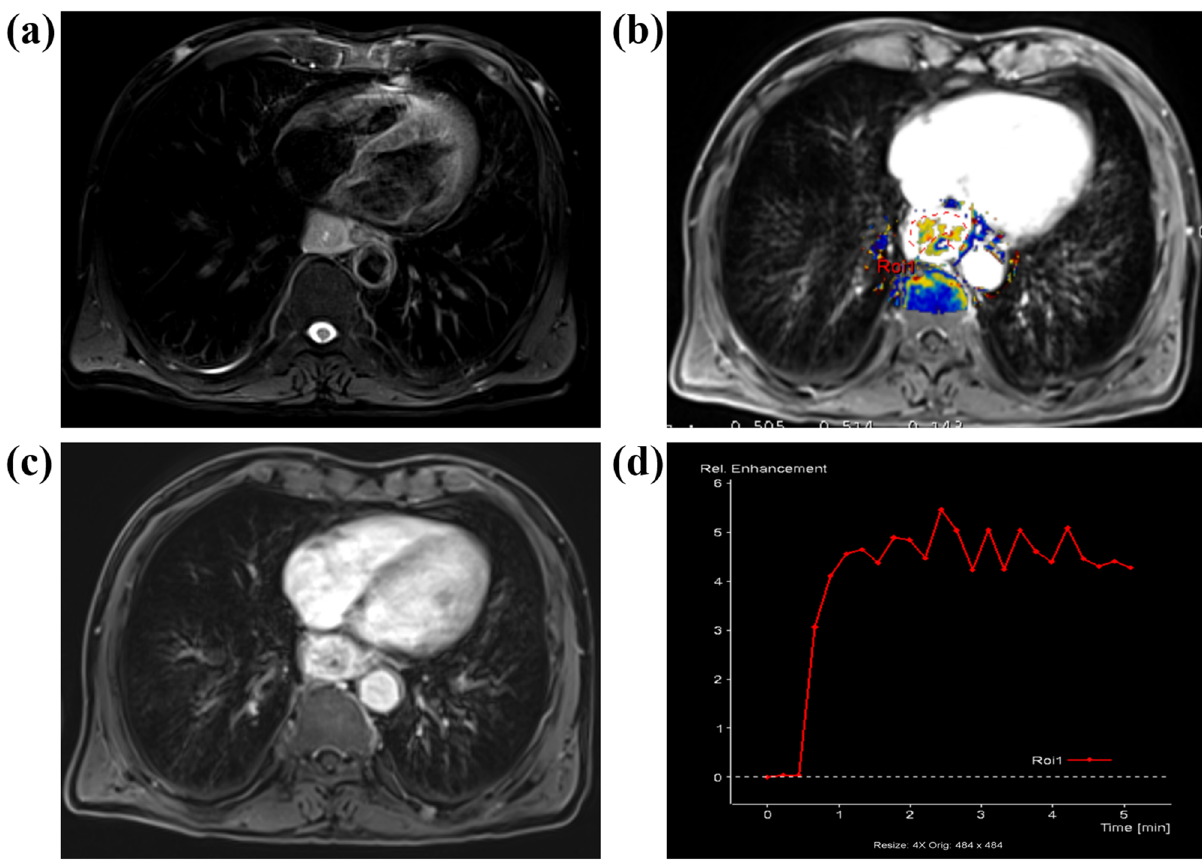
Figure 1. A patient (the age, 50–55) with esophageal carcinoma, perfusion scanning was performed with conventional 3D-VIBE sequence. ( a ) Obvious thickening of the esophageal wall and stenosis of the lumen was shown in the axial T2 fat depression image. ( b ) The pseudo-color map of Ktrans image. ( c ) The 13th stage image of the perfusion images. The inner and outer contours of the lesion are satisfactory, and the respiratory artifact is obvious. ( d ) The dynamic enhancement curve of region of interest (ROI 1) shows fast-rising-platform characteristics; and the perfusion parameters are Ktrans 0.76 min −1 , Kep 1.18 min −1 and Ve